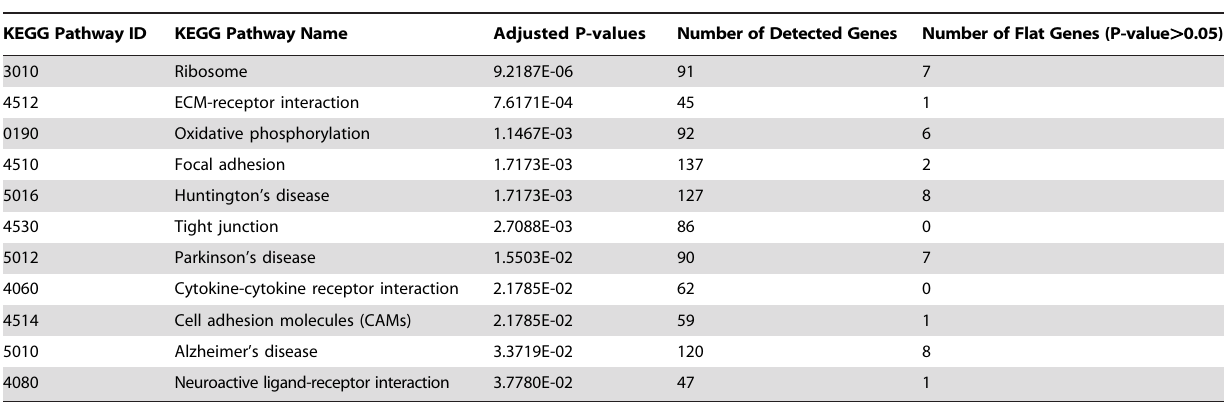
Table 1. List of significant KEGG pathways identified by attract that discriminate between the four cell types (P-value , 0.05).